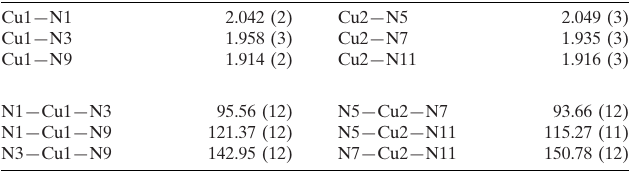
Selected geometric parameters (A˚ , (cid:2)